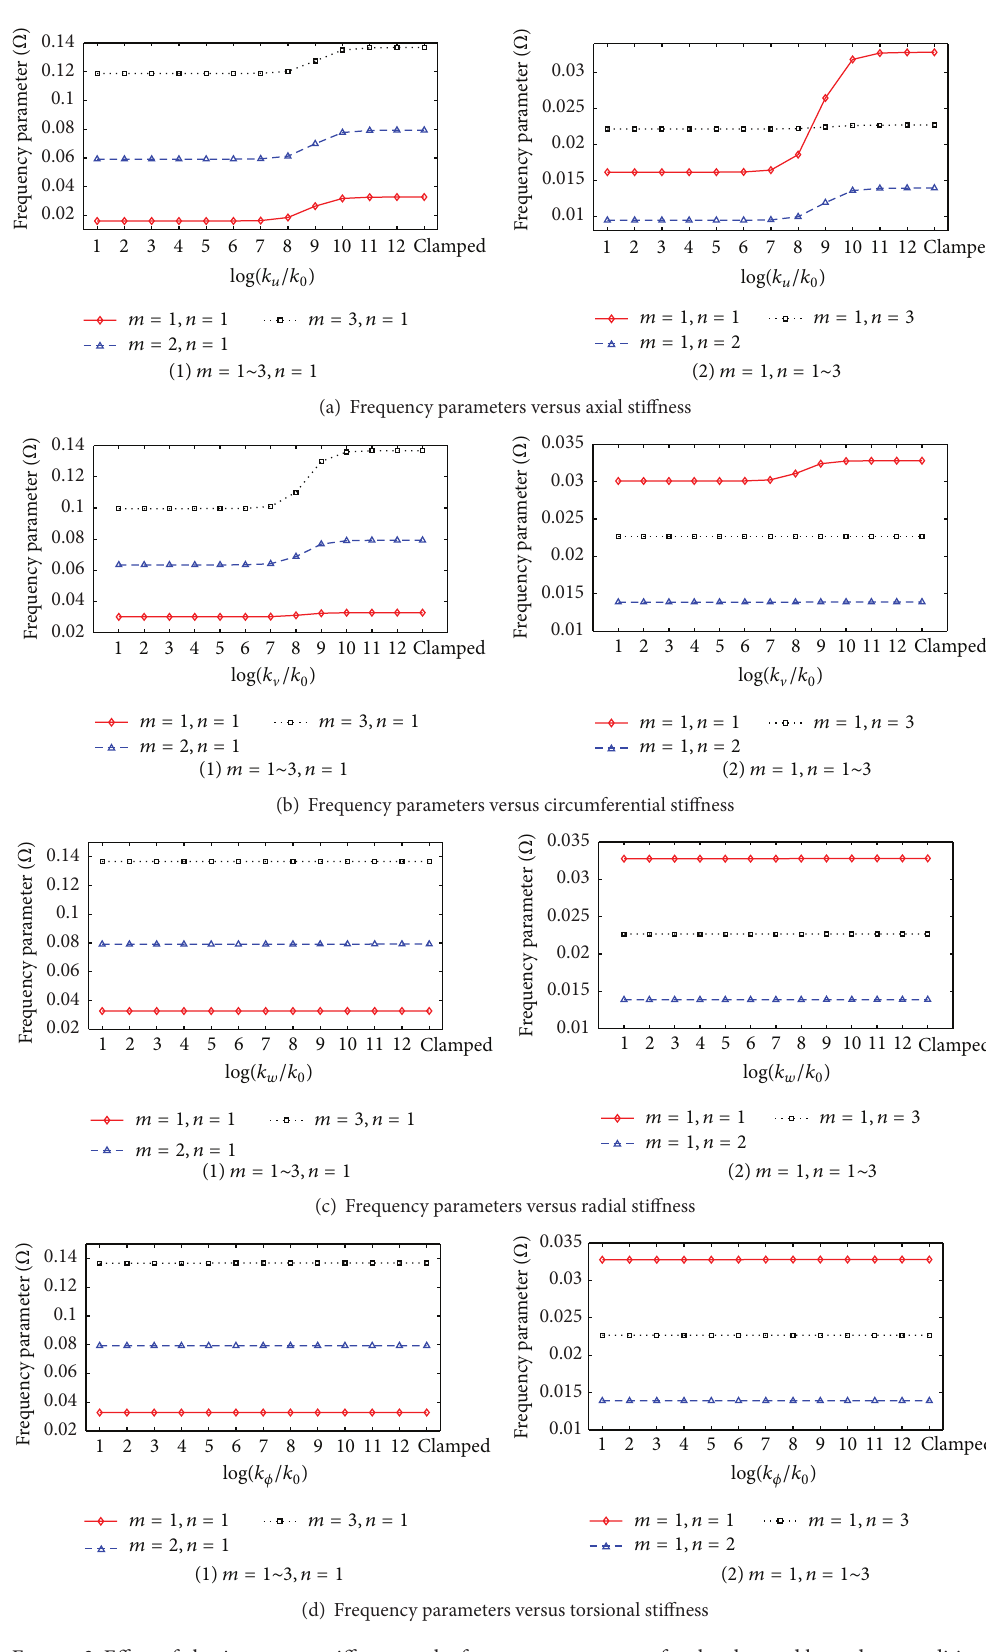
Figure 3: Effect of elastic-support stiffness on the frequency parameters for the clamped boundary